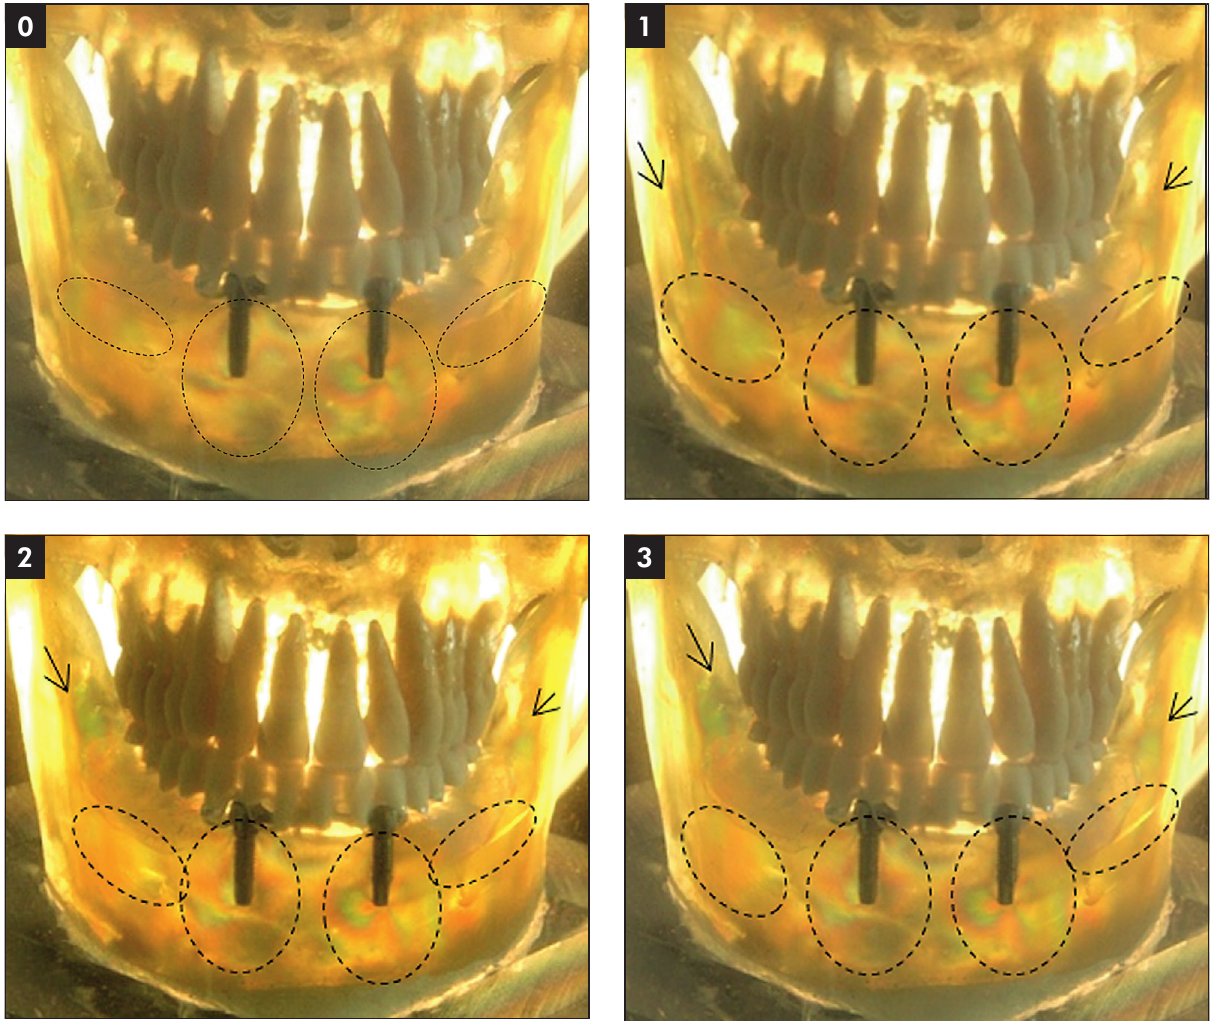
Figure 2 - PAPI: Bar-clip overdenture on two parallel implants, followed by load